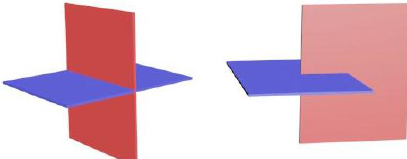
Figure 10. Healing complex CS_SELFINT